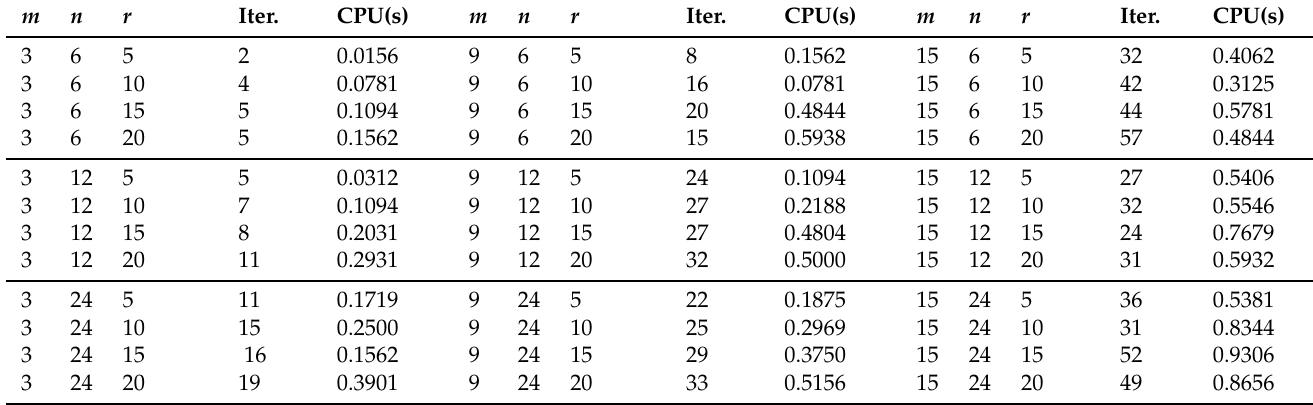
Table 3. The numerical results obtained for minimizing harmonic mean of affine functions in Example